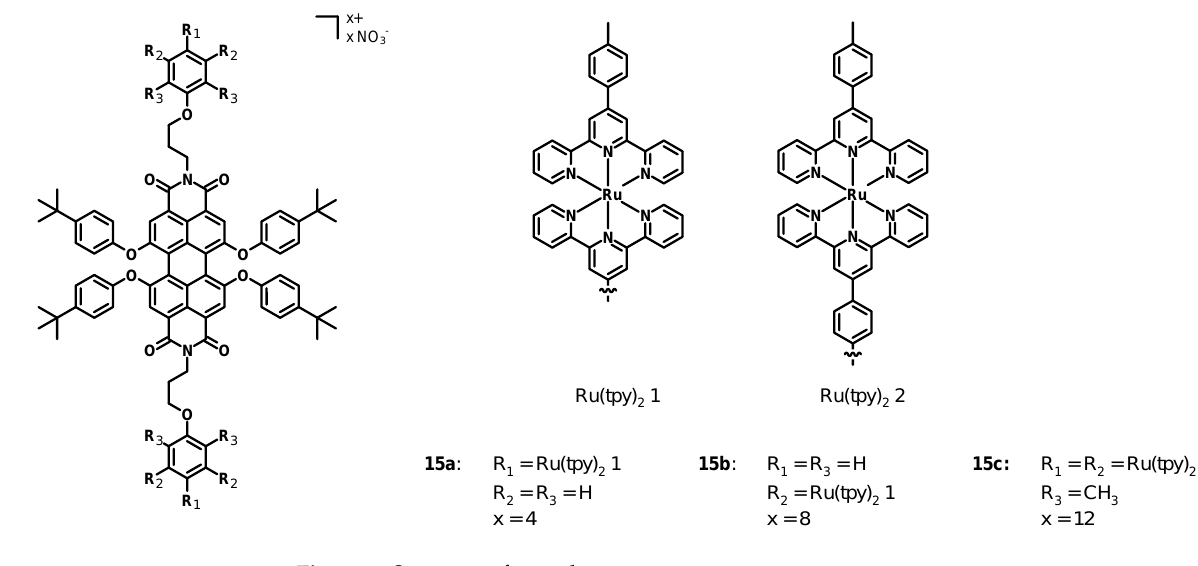
Figure 7. Structure of complexes 15a – c . 497 nm, 1 LC at 288 and 313 nm, and one at 570 nm associated with the perylene π - π* transition. The increasing molar extinction coefficient of the bands at 288, 313, and 497